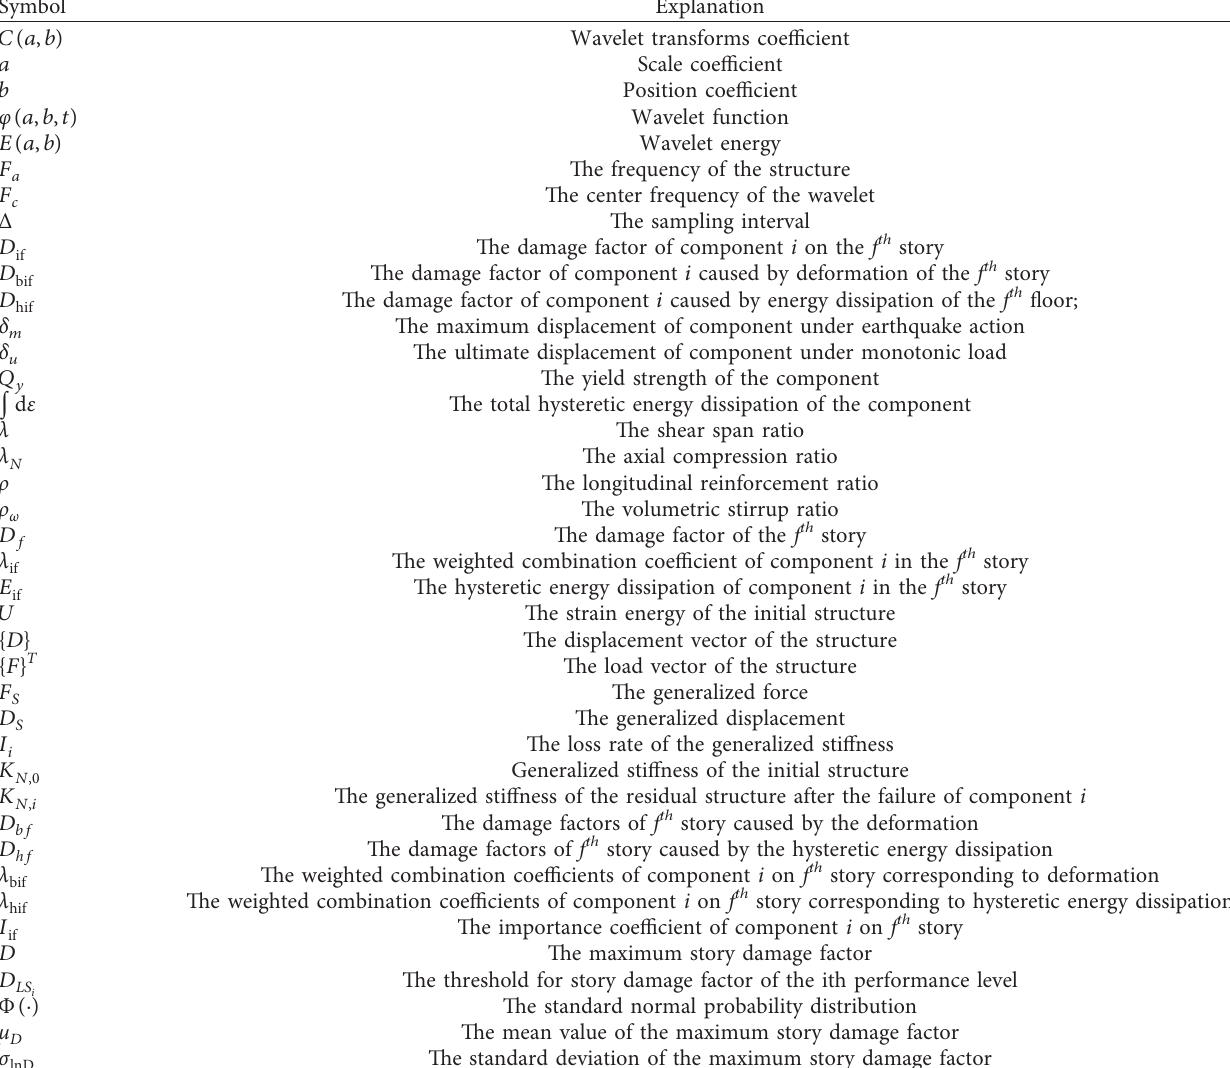
Table 5: Variables involved in the